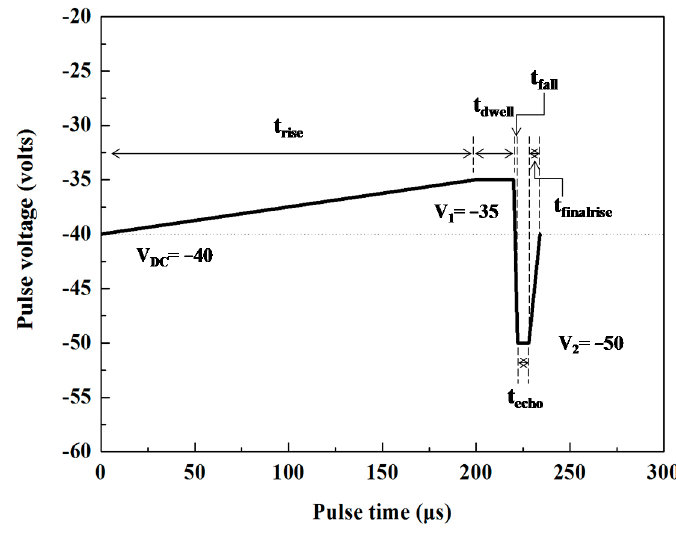
Figure 2. Schematic illustration of the bipolar waveform experimental parameters.